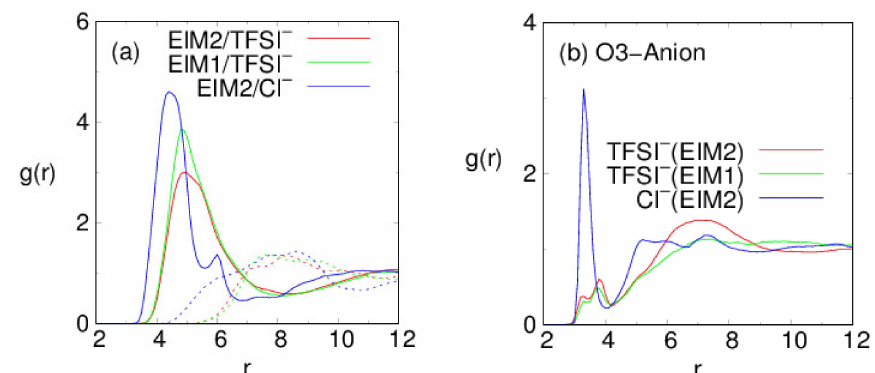
Figure 4. Radial distributions g(r) of ( a ) the cationic EIM2/EIM1 (in solid lines) and TFSI − /Cl − ions (in dashed lines) around the TFSI − /Cl − ions in the PILs, and g(r) of ( b ) TFSI − /Cl − ions around the ether oxygens (O3) of EIM2/EIM1, obtained 300 K, where r (in units of Å) is a distance between the center-of-mass of the anions and ( a ) nitrogen (imidazolium)/( b ) oxygen (ether) atoms of the